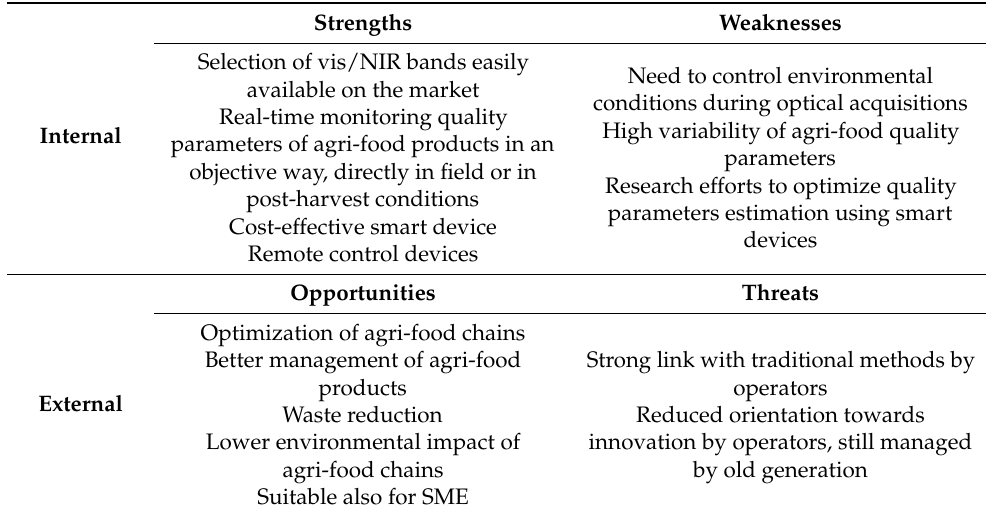
Table 4. Strengths, weaknesses, opportunities, and threats related to the application of the experi- mental outputs and concepts of this work in the agri-food